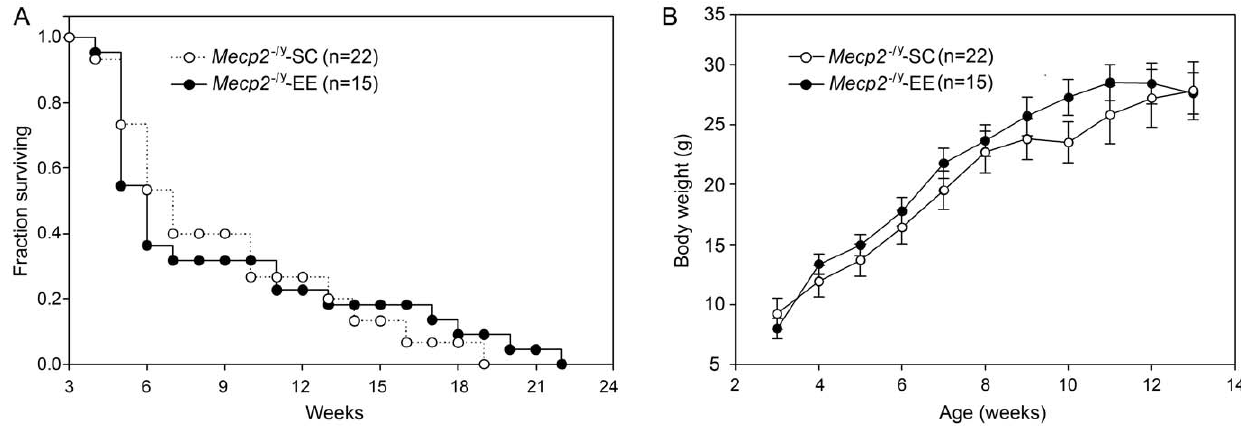
Figure 1. Environmental Enrichment does not modify life span or body weight of Mecp2 2 /y mice. A, Kaplan-Meier plots showing the survival of Mecp2 2 /y -SC (open circles) and Mecp2 2 /y -EE (closed circles) since the initiation of the enrichment period. B, Growth curves of mice showed in A. The body weights of Mecp2 2 /y mice, irrespective of housing conditions, dropped abruptly after 14 weeks and were therefore not included in the graph. Data represent mean 6 SEM. The total number of animals in each group is shown ( n ). No significant differences were found between Mecp2 2 /y -SC and Mecp2 2 /y -EE according to ANOVA tukey test.